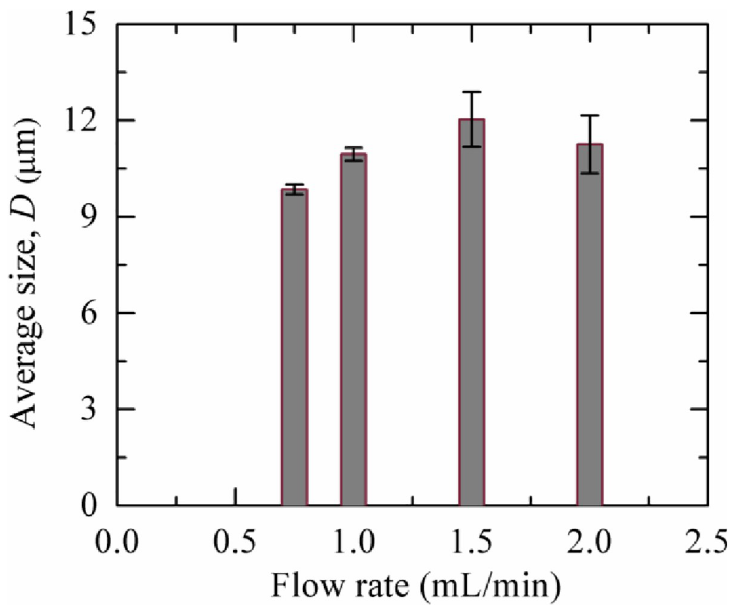
Fig 10. Flow rate dependent average size of purified 40%DOPG/60%DOPC-GUVs using dual filtration technique.